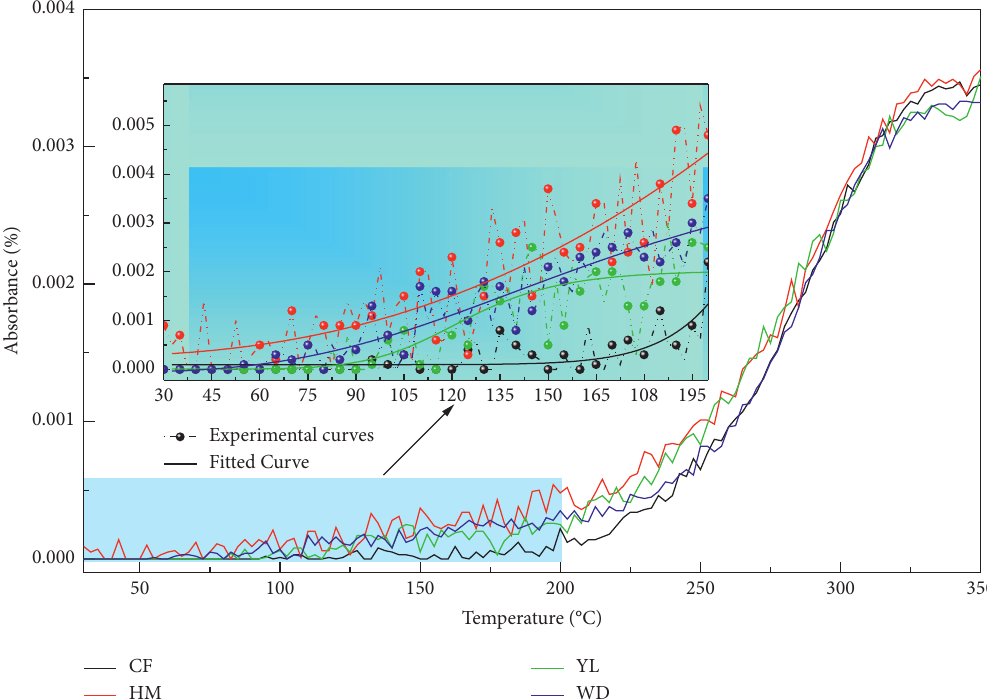
Figure 6: Infrared characteristic peak intensity of CO